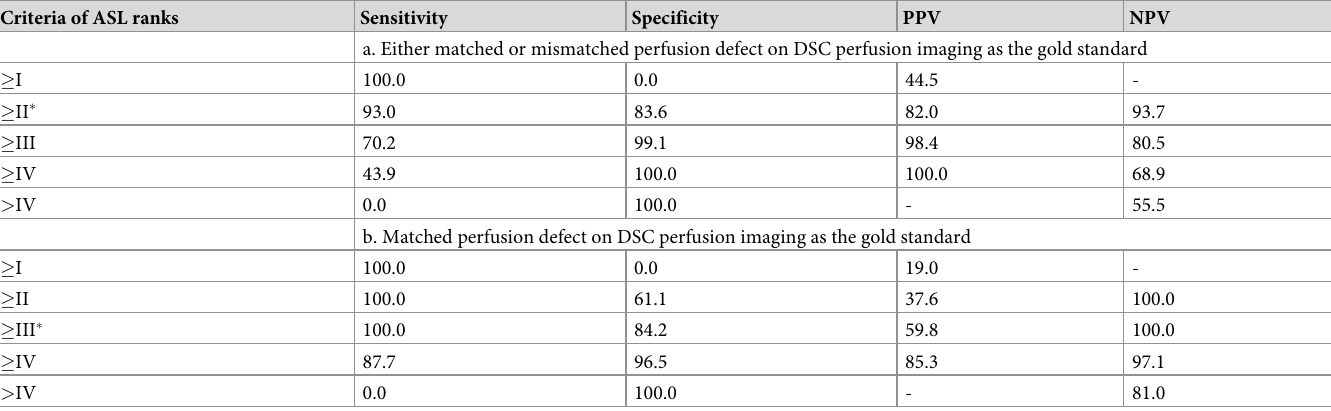
Table 3. Diagnostic performance of the ASL ranking system, using DSC perfusion imaging as the gold standard. Criteria of ASL ranks